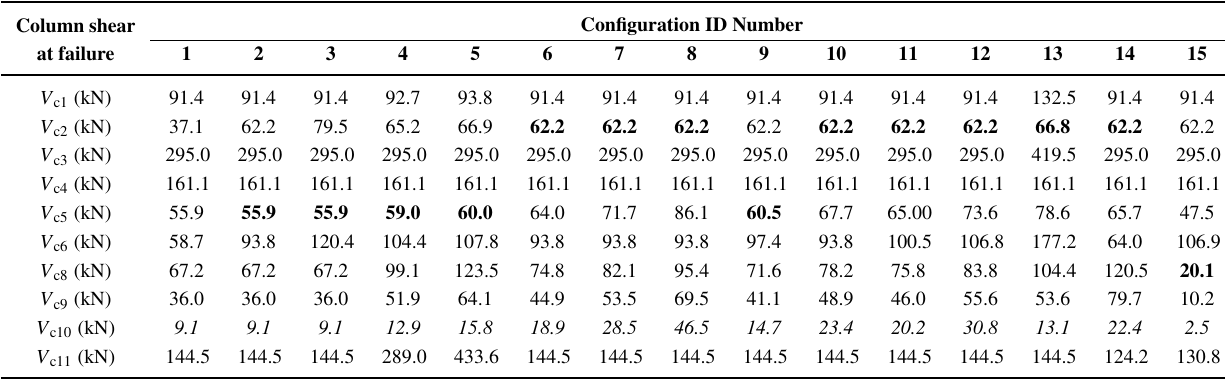
Table 3. Column shear for each configuration case and for every failure mode (to evaluate the strength hierarchy).